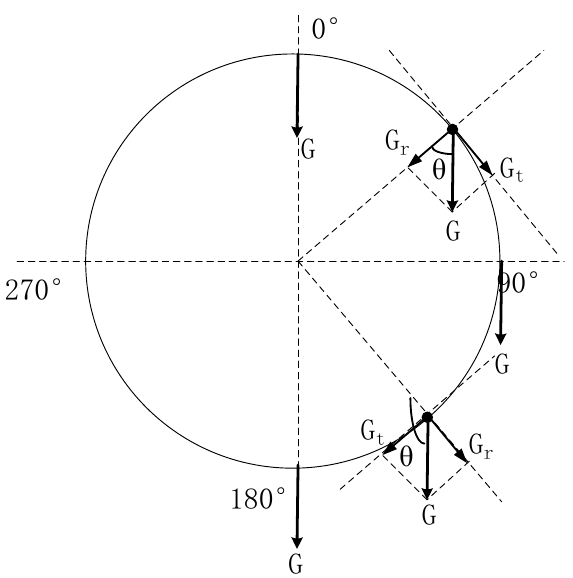
Figure 13. Gravity of molten pool at different welding positions.